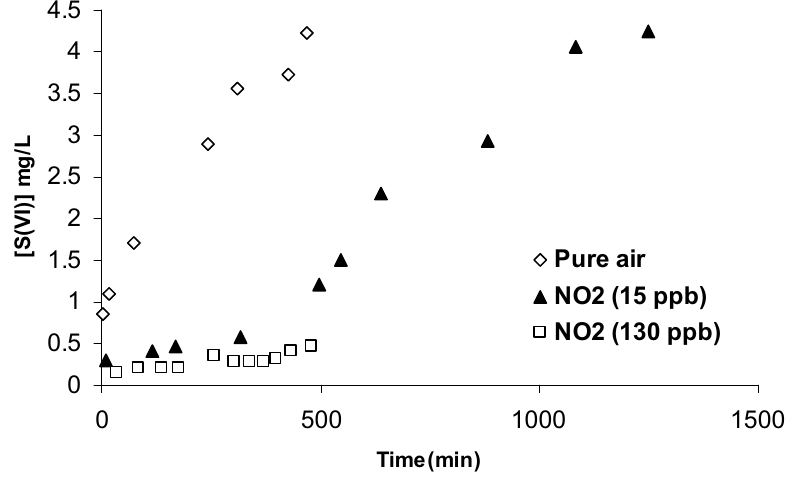
Fig. 2b – Time dependence of [S(VI)] for S(IV) oxidation, [S(IV)] ◦ = 8 mg/L, pH = 3.7, T = 22 ◦ C.